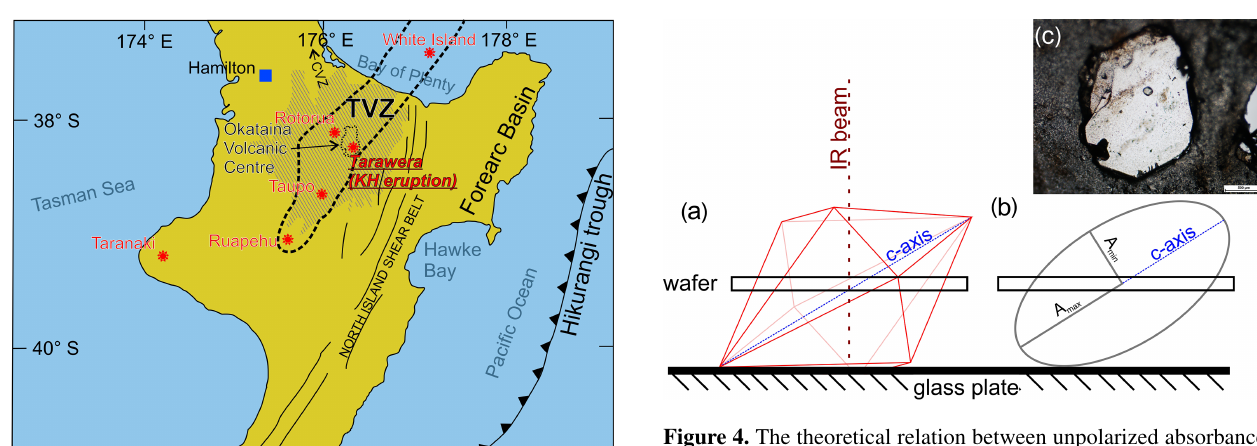
Figure 4. The theoretical relation between unpolarized absorbance of quartz and crystal orientation. (a) A hypothetic euhedral quartz phenocryst (similar to those prepared) as laid on the glass plate onto its pyramidal facet. “Wafer” refers to the section resulting after sam- ple preparation (doubly polished thick section). (b) The unpolarized absorbance indicatrix of a quartz crystal with identical orientation as in (a) (Biró et al. 2017) (c) quartz wafer in epoxy resin after sam- ple